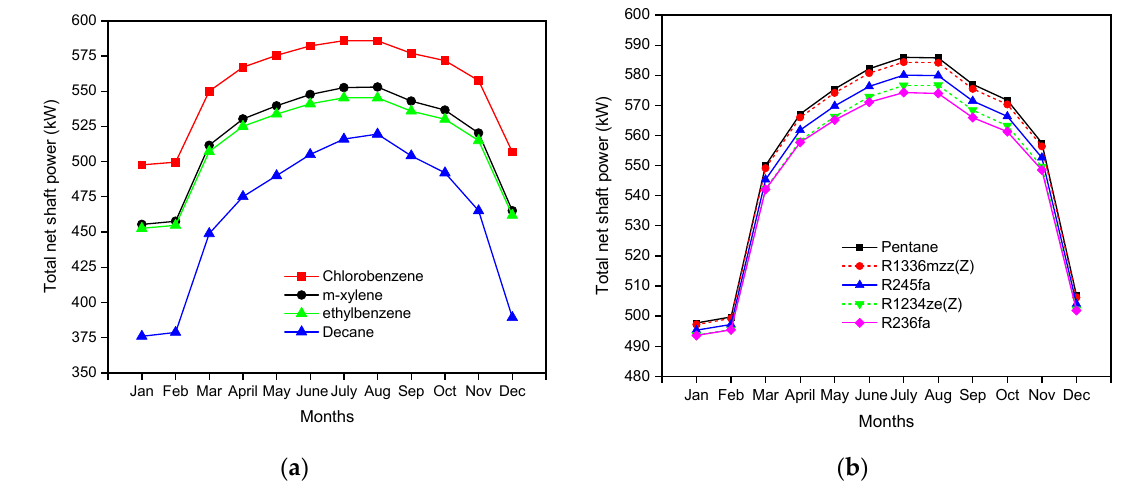
Figure 4. Total net shaft power for different working fluids. ( a ) SORC; ( b ) RORC. The exergy destruction throughout the year for different components is shown in Figure 5. The exergy destruction value of the WHS fluctuated the most during the year with a maximum value of approximately 244 kW in January and a minimum value of 43.69 kW in August. The requirement for hot water was higher while the ambient temperature was lower during winter, and the demand for hot water was lower while the ambient temperature was higher during summer. Mass fraction x of fluid 1 had a higher rate in winter than in summer while heating water in the WHS. In addition, heat exchangers exhibit higher exergy destruction in summer than that in winter because mass fraction x of fluid 1 heated fluid 2 in the heat exchanger, which was fixed at a higher value in summer. The exergy destruction of pump 1 and the recuperator remained fairly stable throughout the year. Pump 2 showed a greater variation in exergy destruction because the mass flow rate of fluid 2 increased as the heat demand decreased. The rate of destruction in the evaporator and turbine 1 fluctuated slightly during the year with a slight increase in summer (July and August). Compared with turbine 1, the condenser and turbine 2 exhibited greater exergy destruction owing to the change in mass fraction x of fluid 1 that operates RORC.